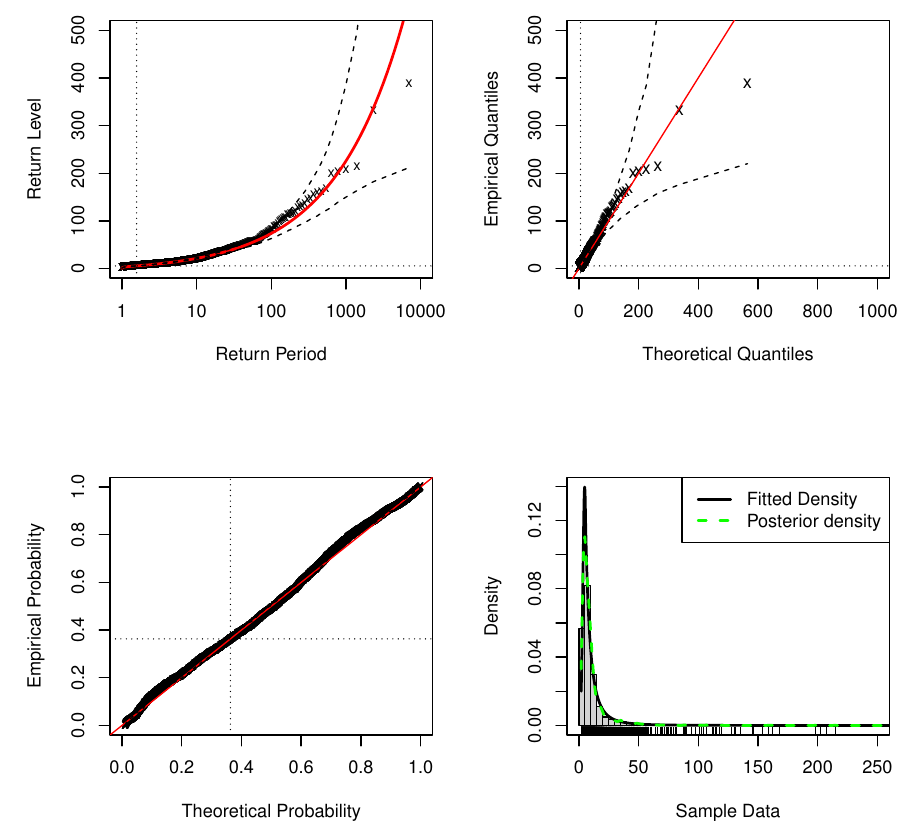
Figure 20. Standard model fit diagnostics for the DPMW-PPR model fitted to the Patuxent river daily flow. (The top left corner is the return level plot, the top right corner is the quantile plot, the bottom left corner is the probability plot, and the bottom right corner is the density